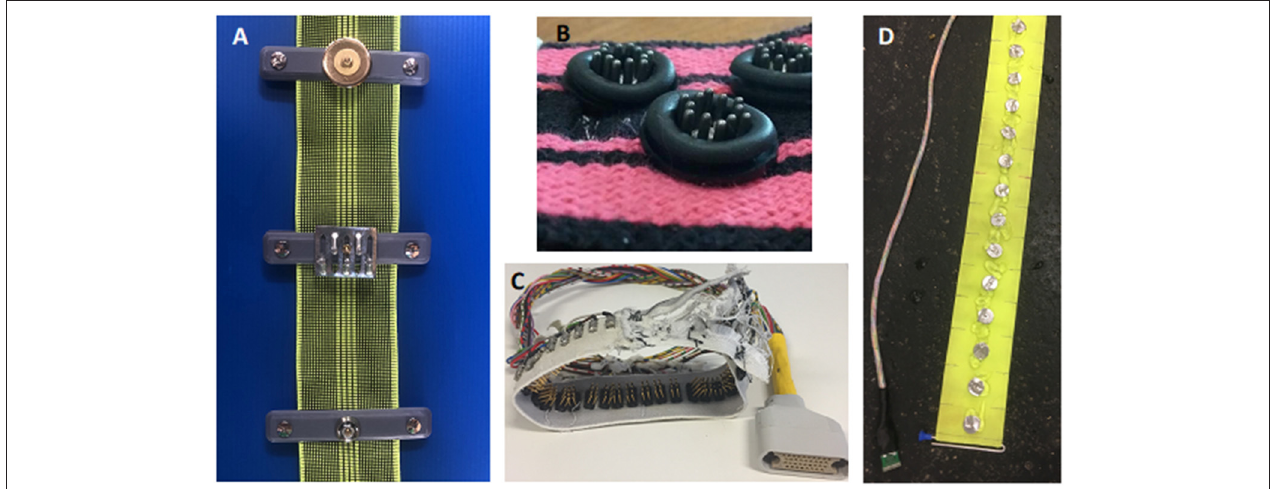
FIGURE 7 | Example of electrode designs. (A) Three Electrode designs for a cow belt top- gold plated flat washer, middle- zinc galvanised spike, bottom- zinc plated rivet. (B) Electrode design for a dog belt. The electrode consists of stainless-steel spikes encapsulated by a rubber ring to allow targeted application of gel. (C) Electrode design for a chicken belt used in lambs and chickens. The electrode is constructed from multiple thin stainless steel spikes to allow penetration through the hair or feathers. (D) Electrode design for a horse belt. The electrodes are medical grade stainless steel flat